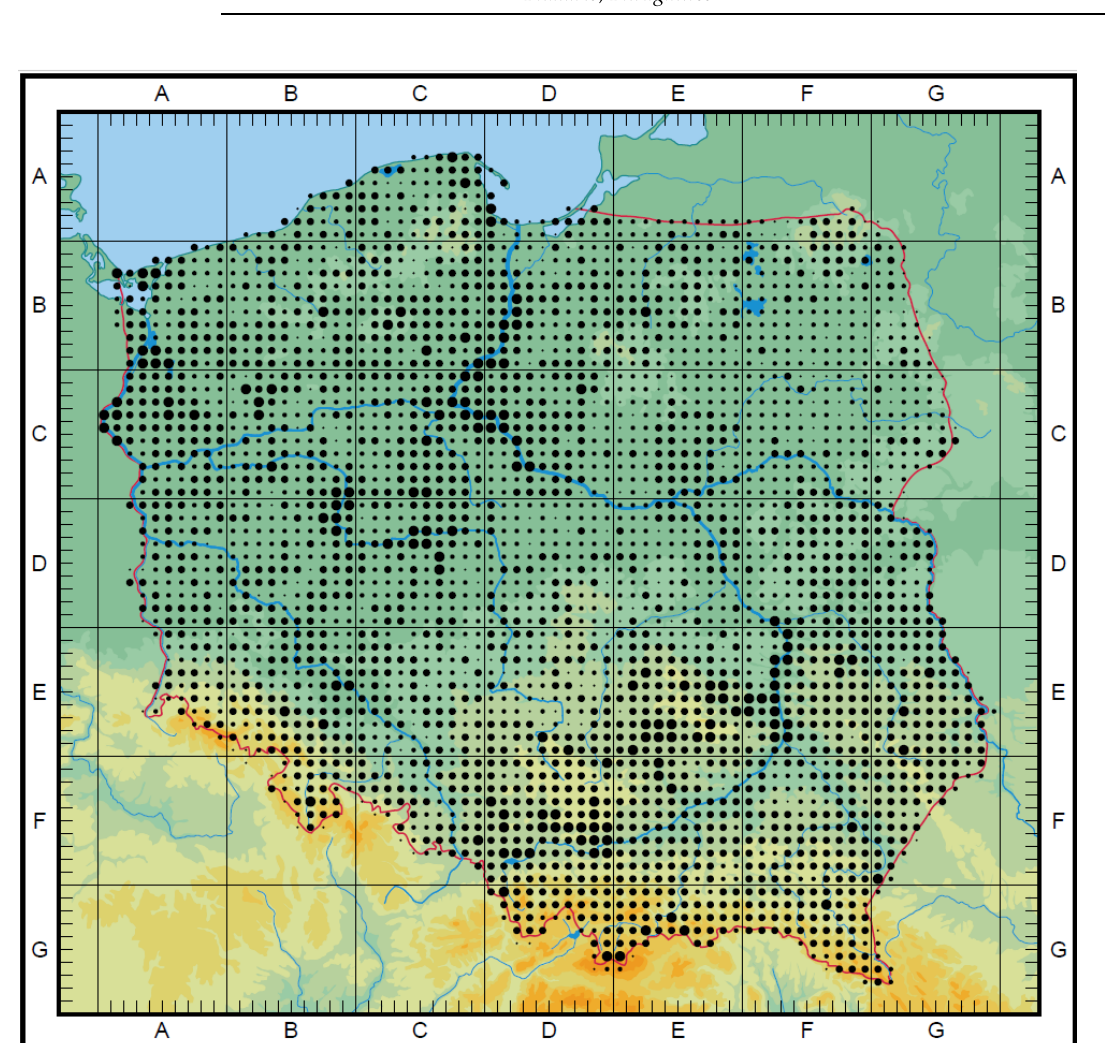
Figure 2. The distribution of crop wild relatives of the Poaceae family in Poland (map). In Poland 8 endemic crop wild relatives “regional” taxa occur (often they are not included in the international databases). The distribution of endemic grass species depends on a specific evolution history and could be different in the case of each species. Interesting to note is the fact that the distribution of endemic grass species is connected to the Vistula river near which the vast majority of localities could be found. The following species are stenochoric: Festuca carpathica F. Dietr., Festuca macutrensis Zapał., Festuca tatrae (Czakó) Degen, Melica transsilvanica Schur, Poa granitica Braun-Blanq., Poa nobilis Skalińska, Stipa joannis Čelak. s. s., and Festuca polesica Zapał. The last one is a steppe spe- cies with an island location, but in this article, it was considered endemic. The aforemen- tioned fescues are alpine species, while F. macutrensis , M. transsilvanica , and S. joannis are a xerothermophilous species. They are restricted to Central Europe and related to the Eur- asian steppe species occurring further east. F. carpatica remains restricted to alkaline bed- rock in the Carpathians. F. tatrae is a narrow endemic of the Tatra Mts. P. granitica and P. nobilis occur only in granite bedrock, P. granitica only at Babia Góra, while P. nobilis only in the Tatra Mts. [54,55]. There are more endemic taxa with lower or controversial taxo- nomic rank, usually treated as subspecies or varieties among Polish CWR grasses. The distribution, habitat preferences, and genetic diversity of some of them are fairly well